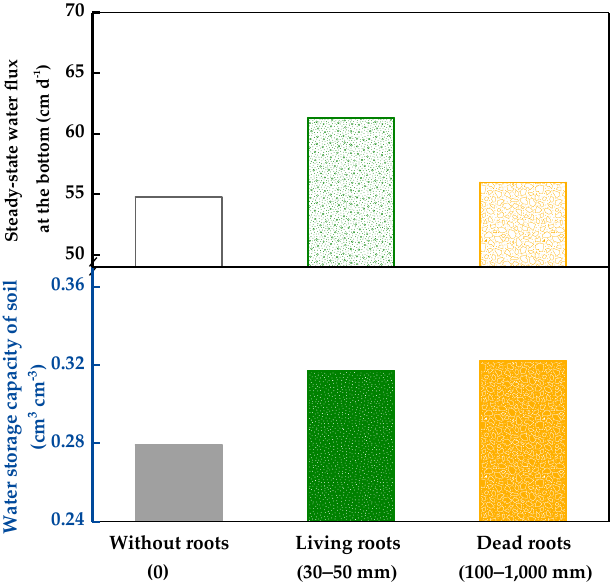
Figure 5. The steady-state water flux at the bottom of containers, water storage capacity of soil, and the diameter of internal pores without or with living and dead roots (soil density is 1.21 g cm -3 ).